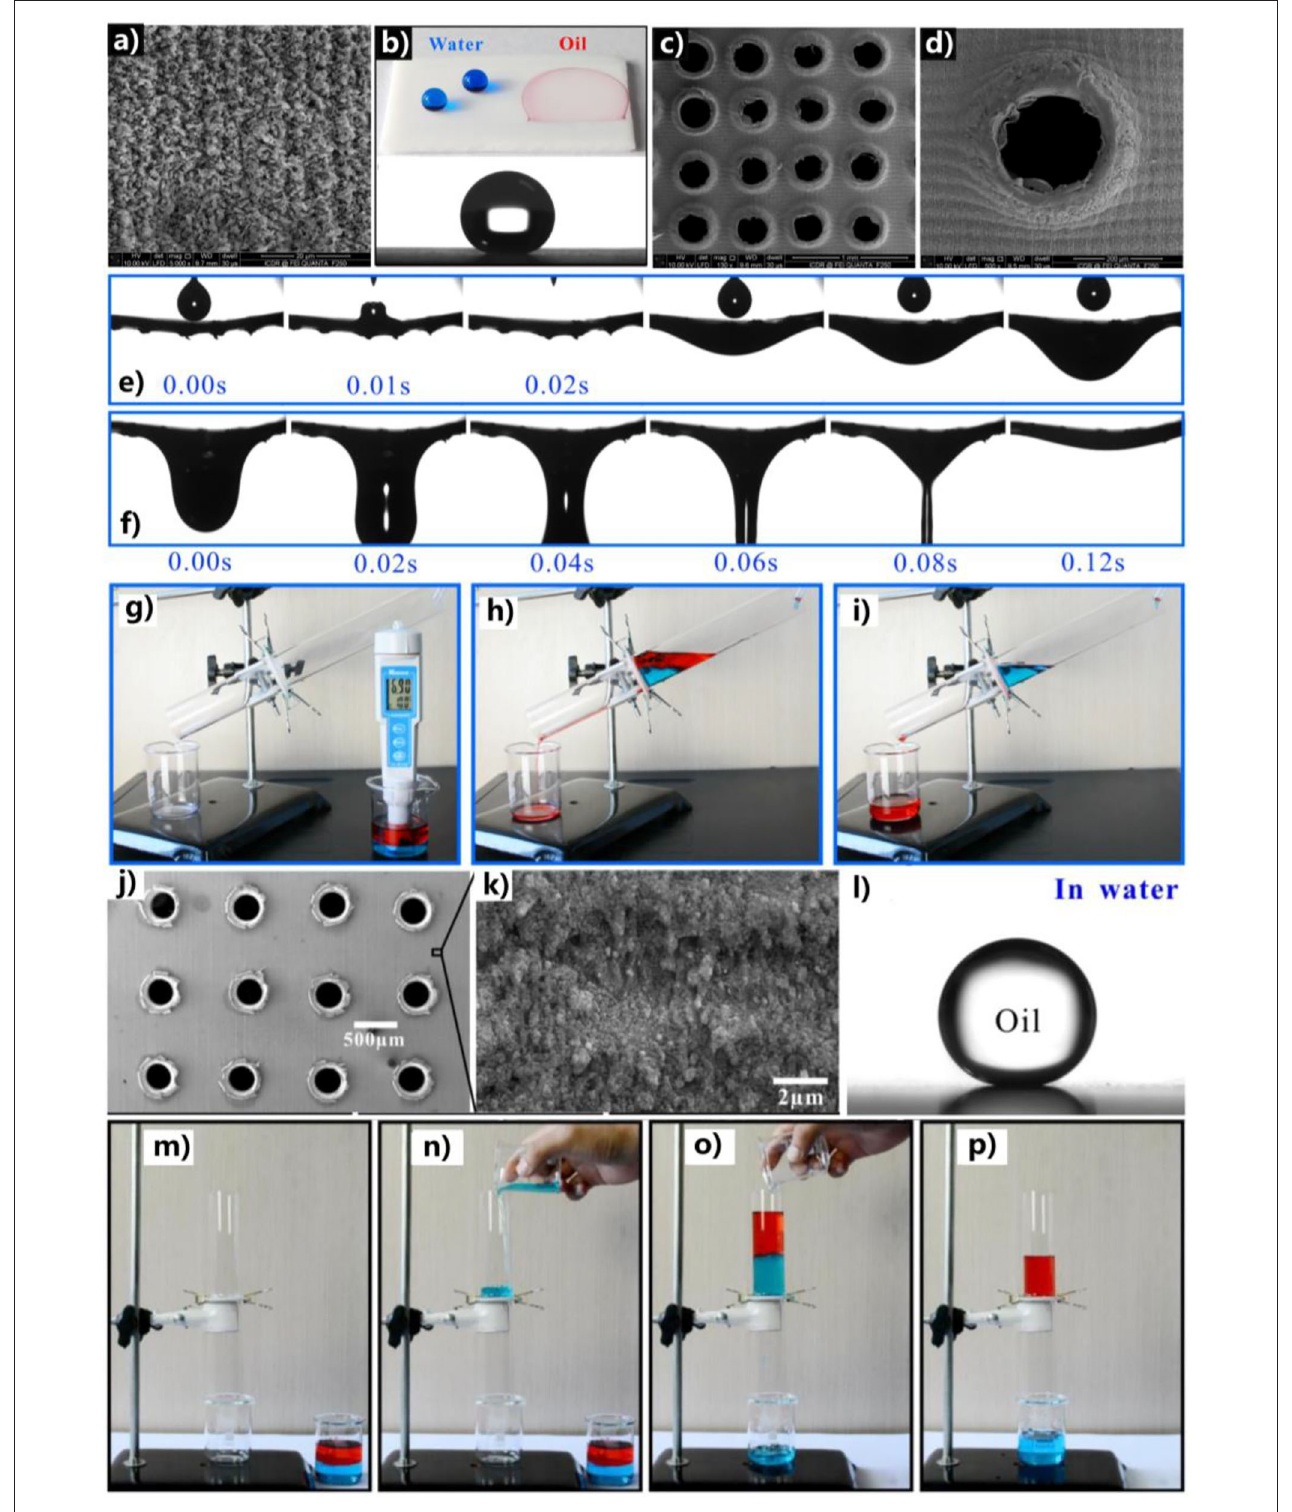
FIGURE 2 | OWS by using the porous superhydrophobic or underwater superoleophobic sheet structured by femtosecond laser. (a) SEM image of the laser-induced rough structure on a PTFE substrate. (b) Superhydrophobicity and superoleophilicity of the laser-structured PTFE sheet. Blue liquid and the below droplet: